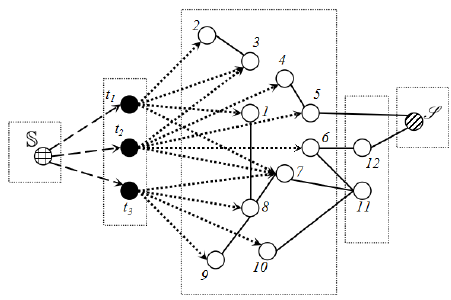
Figure 6. A flow graph can be divided into five parts: super source, target nodes, sensing nodes, relaying nodes, sink